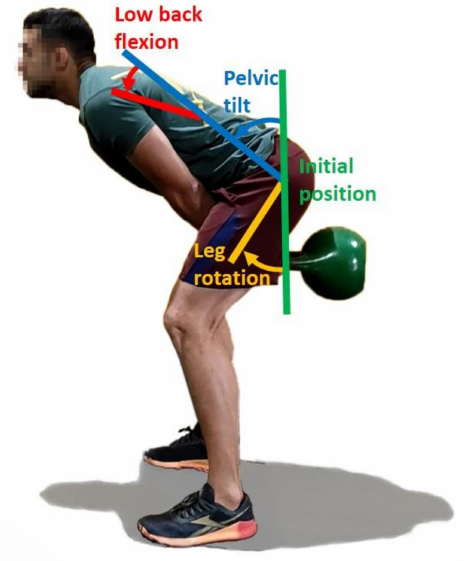
Figure 9. Kinematic